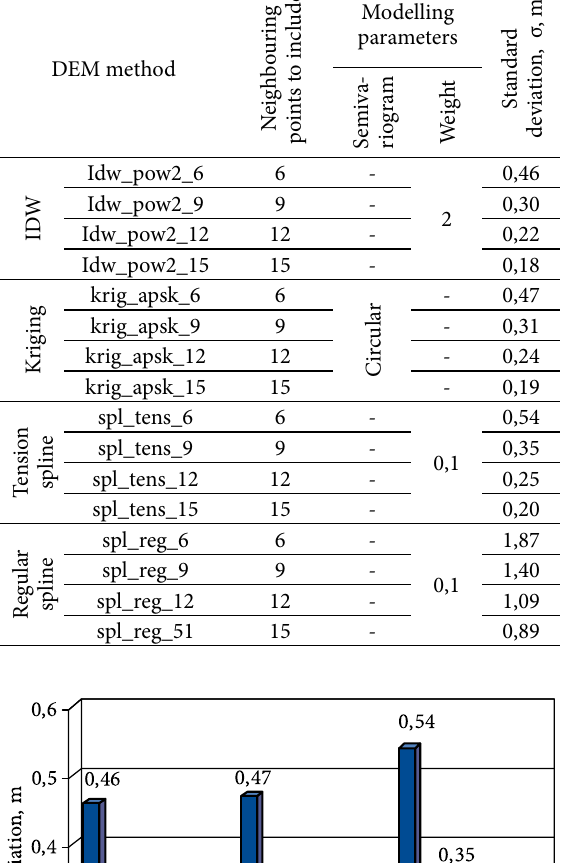
Table 1. DEM accuracy relation with the used method of modelling